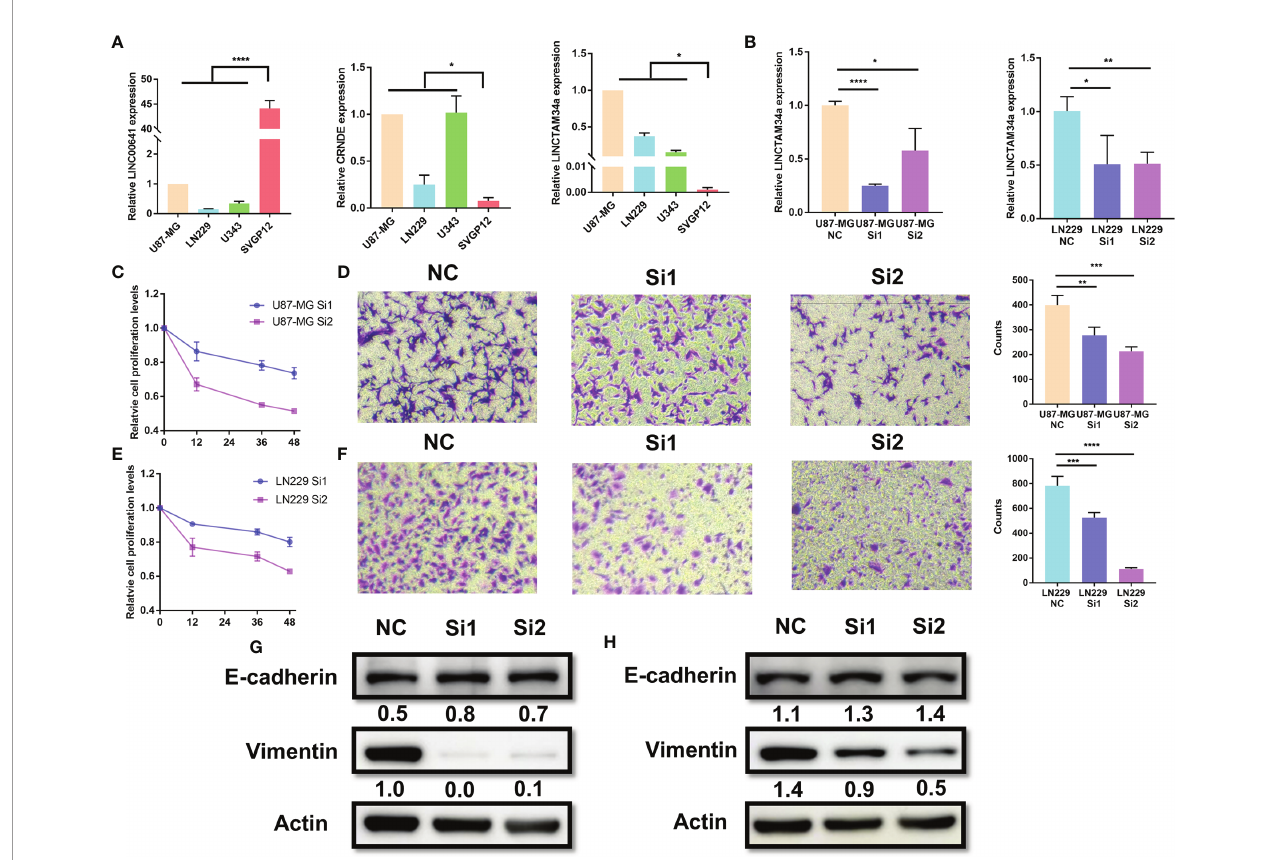
FIGURE 8 | Knockdown of LNCTAM34A reduced proliferation, migration and EMT in glioma cells. (A) The expression levels of CRNDE, LINC00641 and LNCTAM34a in glioma cell lines (U87-MG, LN229 and U343) and normal human astrocytes (SVGP12) as detected by RT – PCR. (B) LNCTAM34A expression levels in U87-MG cells or LN229 cells transfected with siNC or two different speci fi c siRNAs. The CCK-8 assay was used to detect (C) U87-MG cell or (E) LN229 cell proliferation at 0, 12, 36 and 48 h after incubation.The Transwell assay was used to detect (D) U87-MG cells or (F) LN229 cell migration at 24 h after incubation. (G) The expression of E-cadherin and Vimentin in U87-MG cells and (H) LN229 cells was measured by using Western blotting. ****p < 0.0001, ***p < 0.001, **p < 0.01, *p < 0.05.